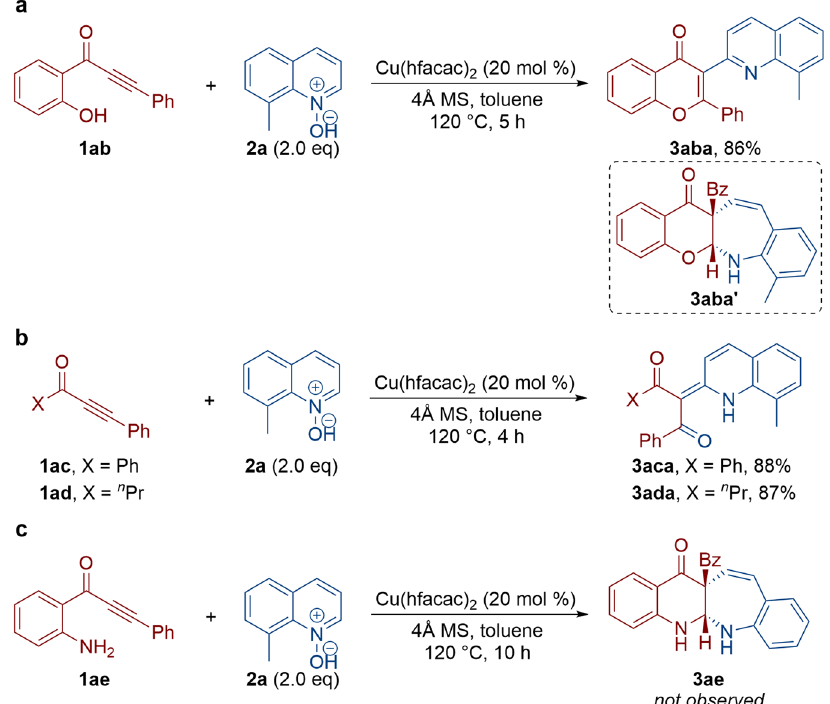
Fig. 5 Control experiments. a Hydroxyl-substituted alkynone was used. b Unsubstituted alkynone was used. c Alkynone without Boc at the amino group was used.